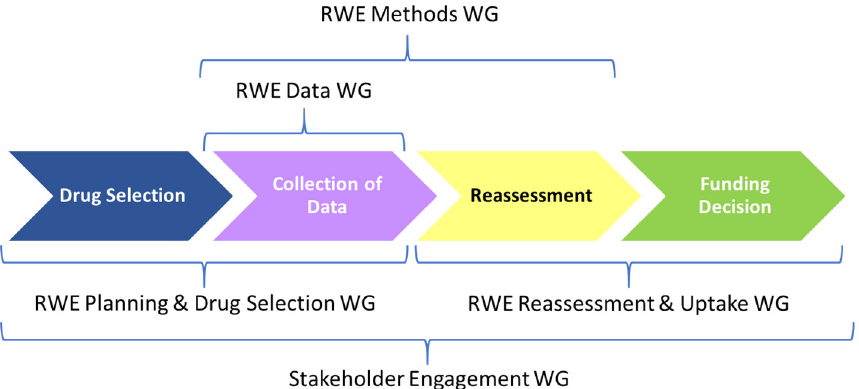
Figure 1. The Canadian Real-world Evidence Value of Cancer Drugs (CanREValue) project real-world evidence (RWE) working groups (WGs) and their roles within the development of the framework.